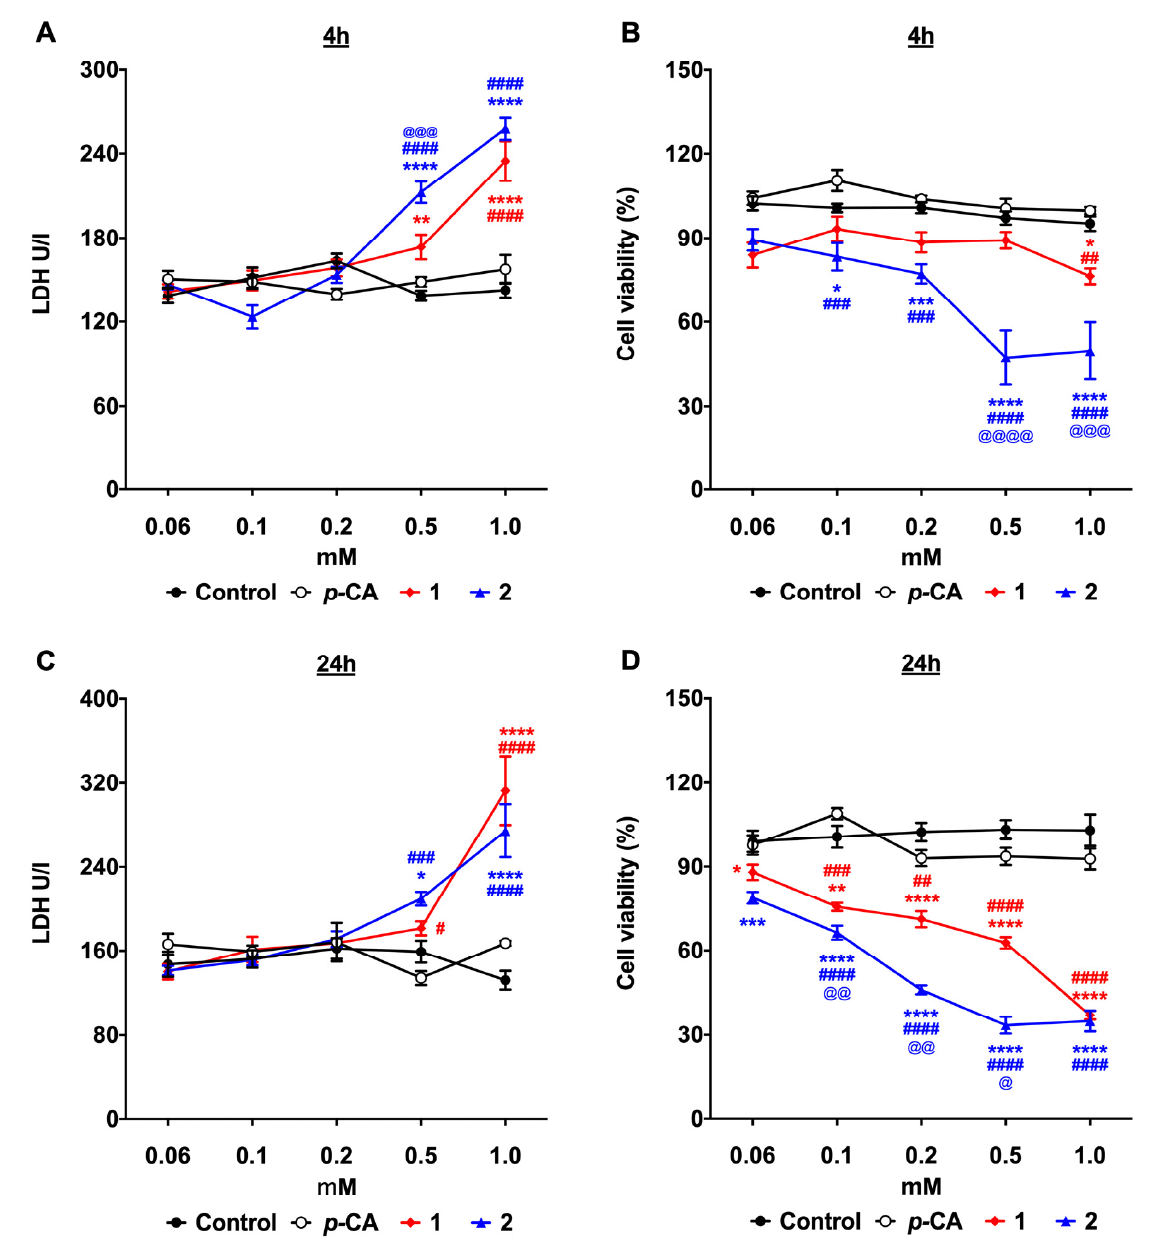
Figure 3. p -Coumaric acid esterification improves the cytotoxicity against the SK-MEL-25 melanoma cells. Human SK-MEL-25 melanoma cells were incubated with different concentrations of p -coumaric acid ( p -CA, white circles), ethyl p -coumarate ( 1 , red lozenges), or n -butyl p -coumarate ( 2 , blue triangles) for 4 h or 24 h. Control cells were incubated with the equivalent concentrations of DMSO. ( A , C ) LDH quantification in the culture supernatants; ( B , D ) frequency of the viable cells. * p < 0.05, ** p < 0.01, *** p < 0.001, **** p < 0.0001 compounds 1 or 2 vs. control; # p < 0.05, ## p < 0.01, ### p < 0.001, #### p < 0.0001 compounds 1 or 2 vs. p -CA; @ p < 0.05, @@ p < 0.01, @@@ p <